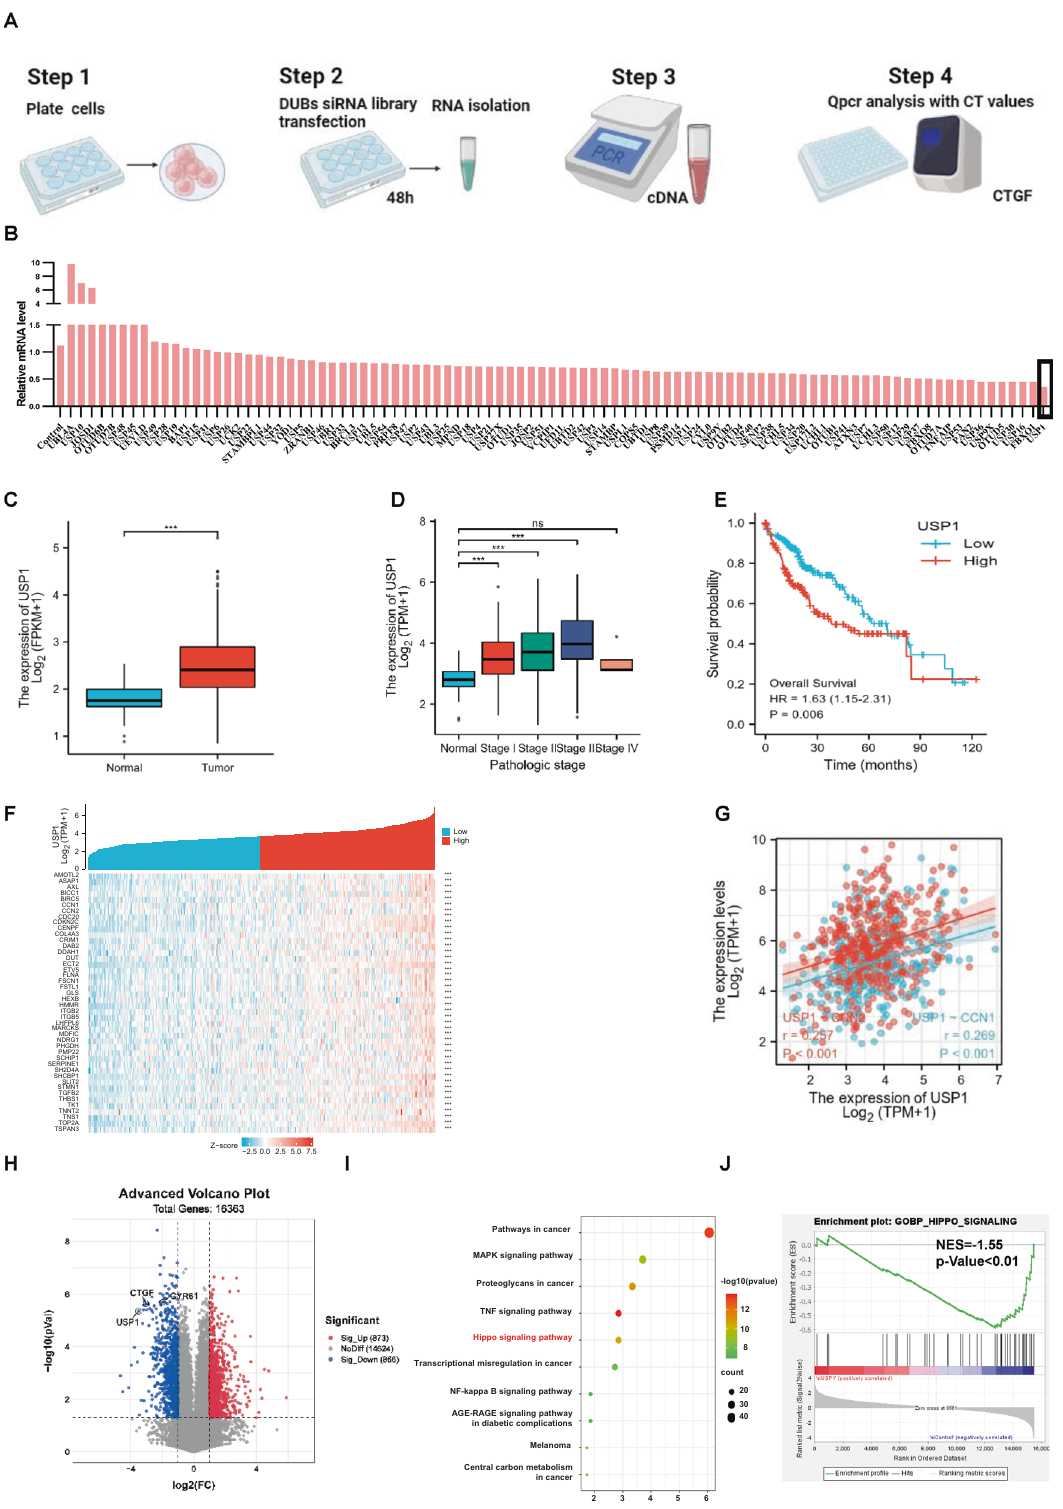
immunopreciptated with speci fi c antibodies overnight. Antibodies used were IgG (#026102; Life Technologies) and TAZ (#4883; Cell Signaling). Complexes were recovered on ChIP-grade Protein A/G plus agarose bead (#26195; Life Technologies). qPCR was performed using primer sets fl anking the predicted TEAD binding sites. Primer sequences of CTGF used are as follows: 5 ′ -TGTGCCAGCTTTTTCAGACG-3 ′ ; R 5 ′ - TGAGCTGAATGGAGTCCTACACA-3 ′ .